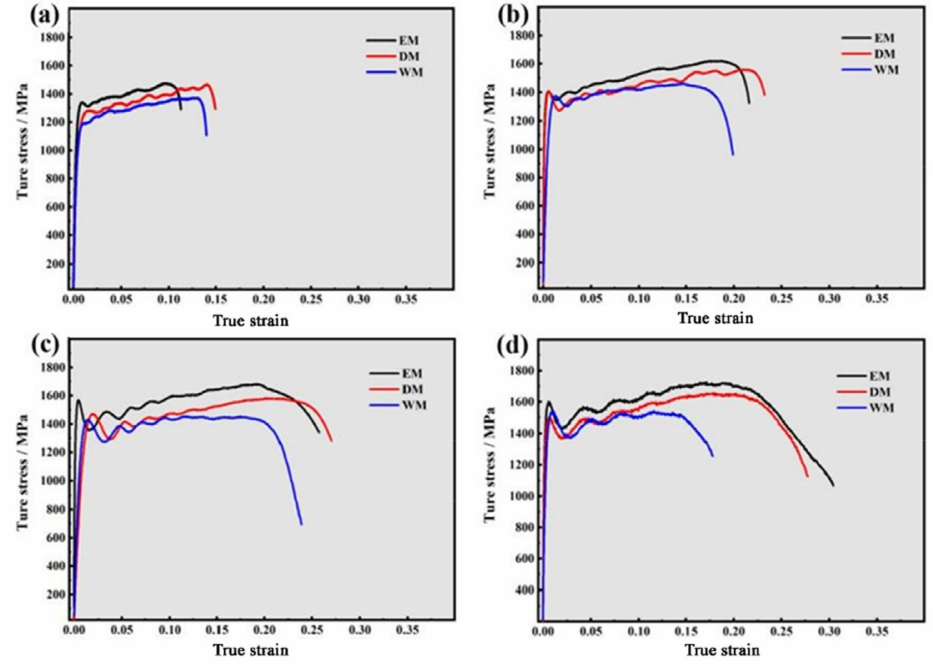
Figure 5. True stress–strain curves of samples with EM, DM and WM at different strain